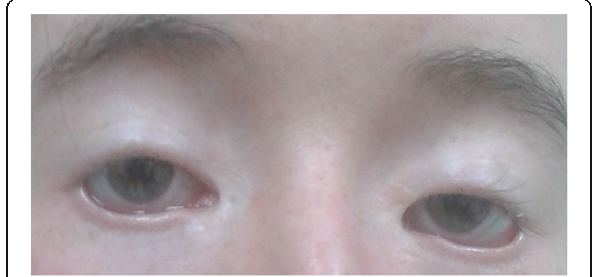
Fig. 1 Ophthalmological phenotype of the study